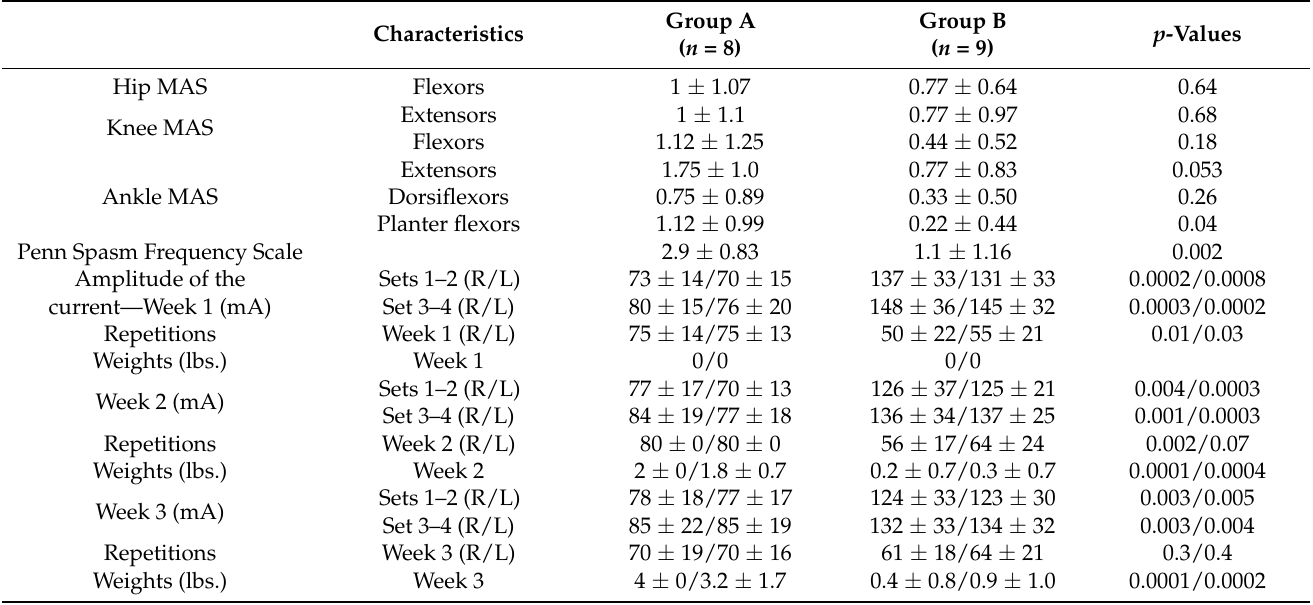
Table 2. Modified Ashworth Scale (MAS), Penn spasm frequency scale, amplitude of NMES-current, for SCI groups with different musculoskeletal qualities. Values are presented as mean ± standard deviation